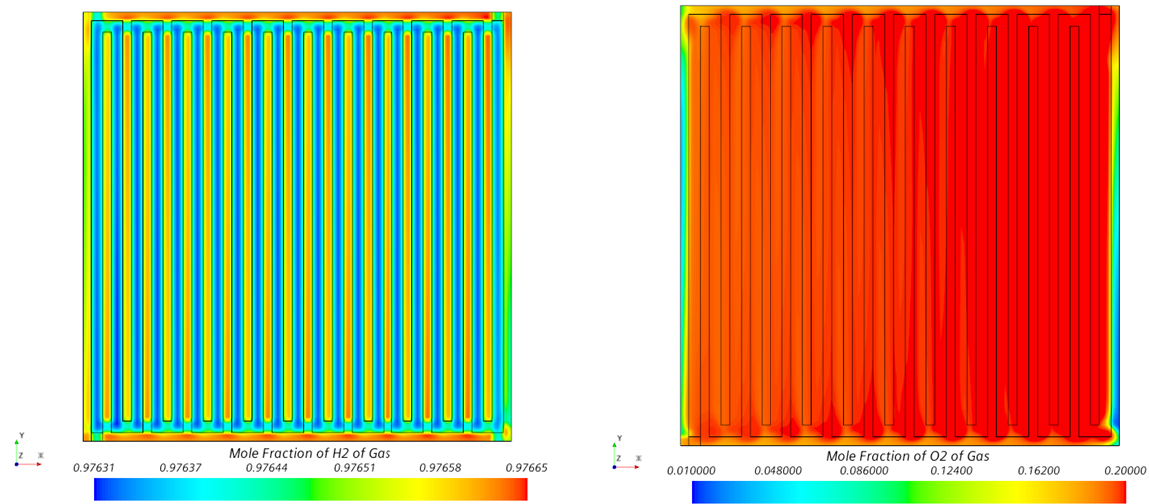
Figure 6. Section views of hydrogen ( left , anode side) and oxygen ( right , cathode side) mole fraction fields for the 0.7 V case at CL surfaces.